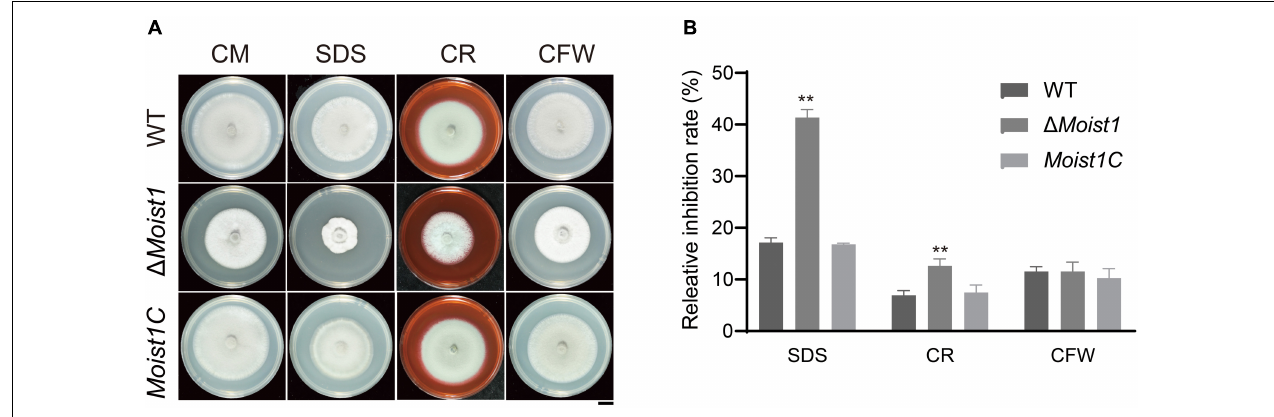
FIGURE 4 | Deletion of MoIst1 increases sensitivity to cell wall integrity stress. (A) SDS (0.005%), CFW (30 µ g/ml), and CR (600 µ g/ml) were added separately to CM to culture WT, (cid:49) Moist1 , and Moist1C . Bar = 1 cm. (B) Relative inhibition rates of WT, (cid:49) Moist1, and Moist1C on CM with SDS (0.004%), CFW (30 µ g/ml), and CR (600 µ g/ml). The standard deviation is represented by error bars. Tukey’s test was used to test significant differences: ** P < 0.01.